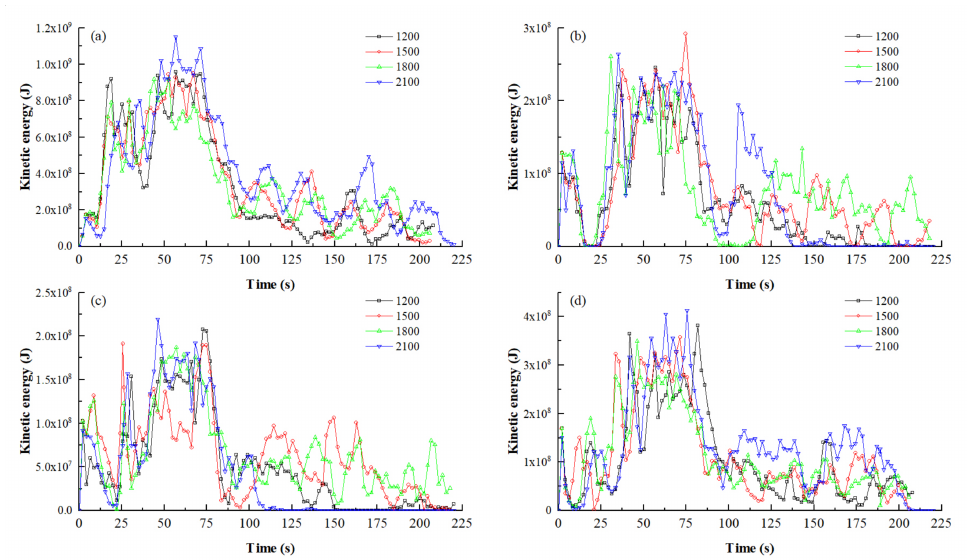
Figure 11. Influence of debris flow density on kinetic energy of boulders with different shapes, ( a ) spherical, ( b ) cuboid, ( c ) rhombohedron, ( d ) cube.